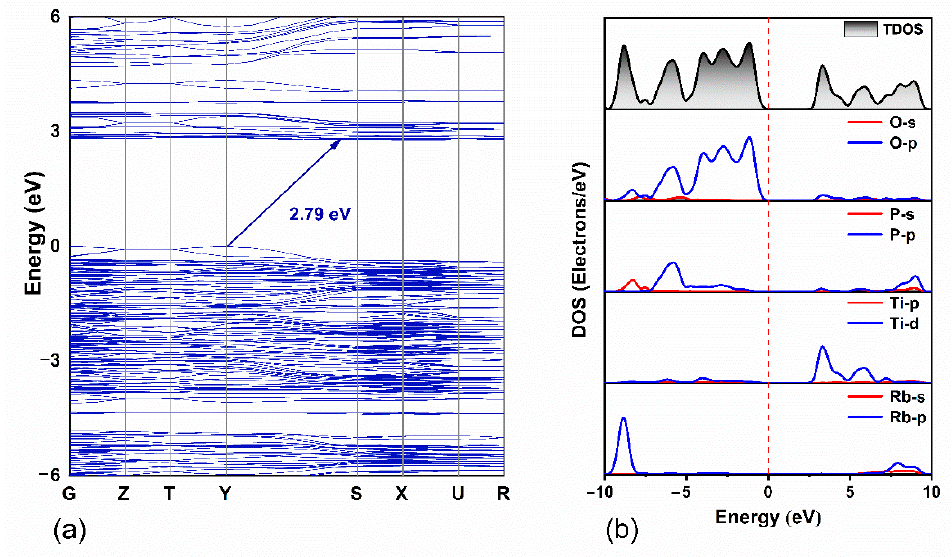
Figure 7. Theoretical calculation of Rb 3 Ti 3 P 5 O 20 . ( a ) Energy band structure; ( b ) TDOS and PDOS curves. The dashed line in the figure is the Fermi energy level (0.0 eV).